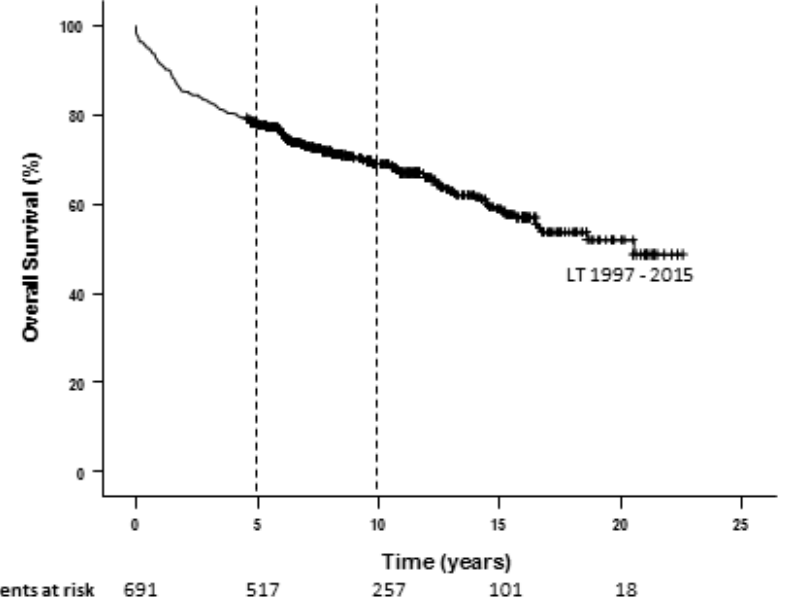
Figure 1. Kaplan-Meier curve for overall survival for HCC following LT in Australia and New Zealand since 1997.